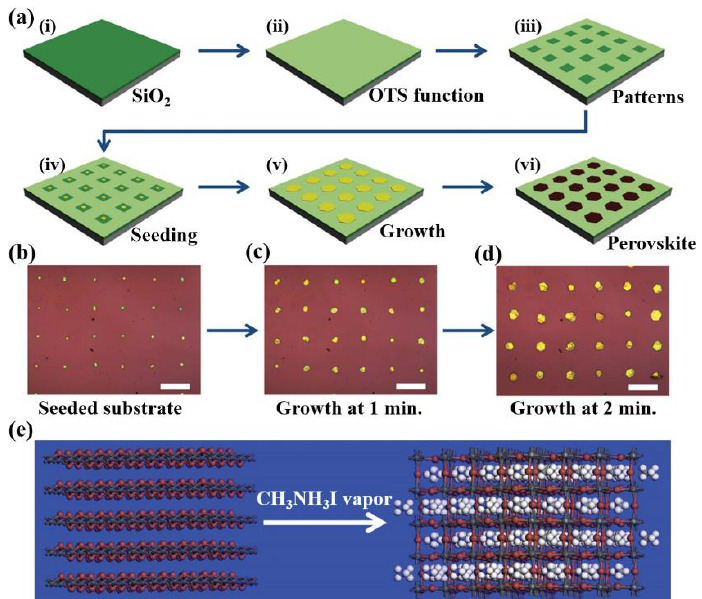
Figure 9. Schematic illustrations ( a ) the whole process of perovskite crystal arrays; (i) cleaning a SiO 2 wafer, (ii) OTS deposition for hydrophobic surface formation by self-assembled method, (iii) patterned, and peeled off the OTS for desired-patterned hydrophilic surface, (iv) flowing an aqueous PbI 2 solution to create PbI 2 seeds only in hydrophilic areas, (v) dip the surface with PbI 2 seeds into saturated PbI 2 solution for growth to a microplate, and (vi) exposed the surface with PbI 2 microplates into methylammonium iodide vapor to produce perovskite crystal arrays. ( b ) optical image of PbI 2 seeds as prepared (iv). ( c , d ) the optical images obtained after immersing the substrate with PbI 2 seeds into saturated PbI 2 solution for 1 min ( c ) and 2 min ( d ). Scale bars are 40 μm. ( e ) the transforming process from PbI 2 layer to perovskite crystal by intercalating with CH 3 NH 3 I vapor. Reprinted with permission [67]. Copyright 2018, American Association for the Advancement of Science.